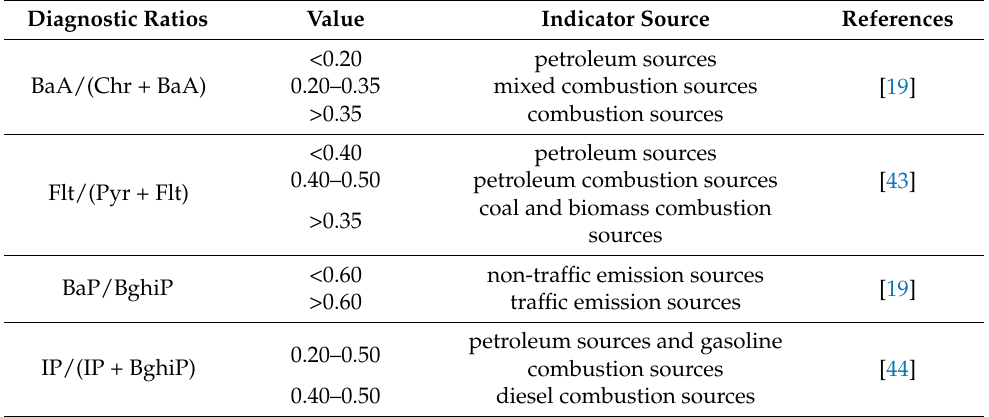
Table 2. PAHs diagnostic ratios used as a source